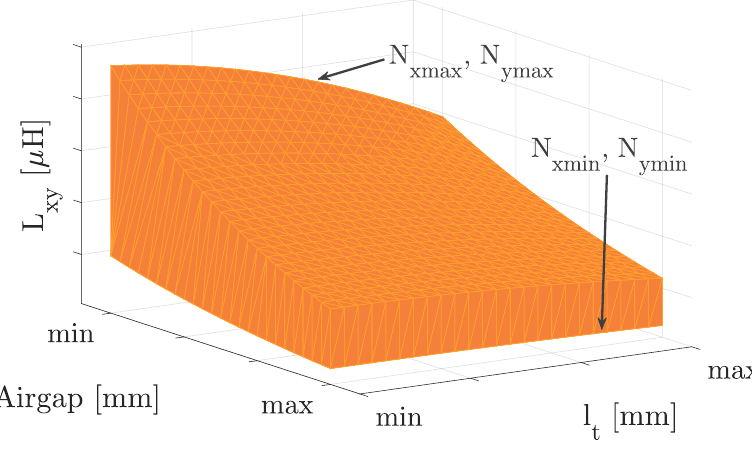
Figure 4. Volume of L xy = f ( N x , N y , airgap , l t